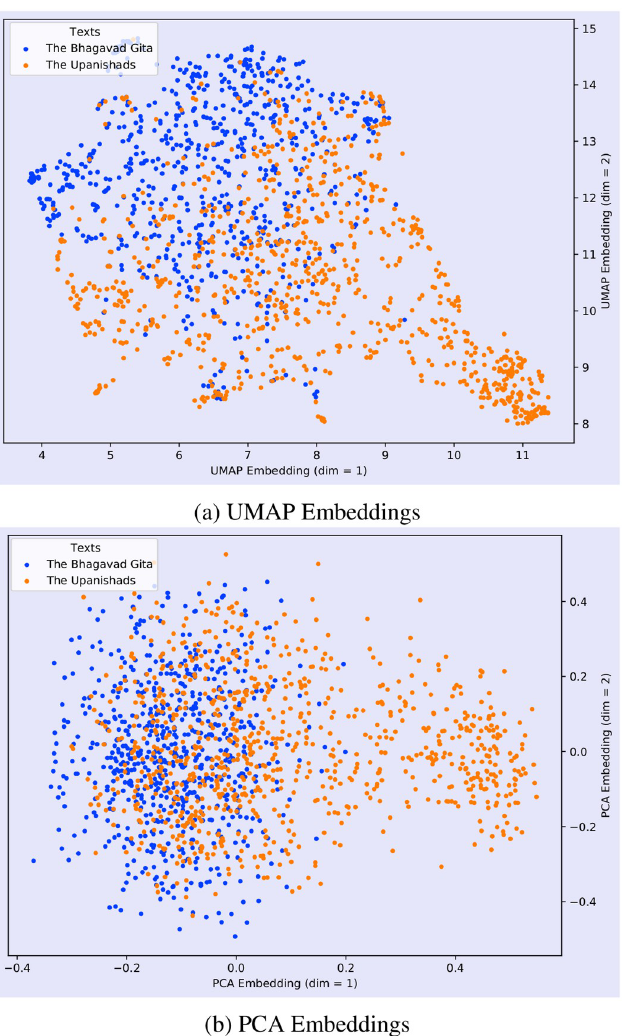
Fig 13. Comparison of dimensionality reduction and visualisation by PCA and UMAP for the combined semantic space of the Bhagavad Gita (Eknath Easwaran) and the Upanishads (Eknath Easwaran). Note that the PCA has 4.4% explained variance ratio for dim = 1 and 3.7% for dim = 2, taken from total of 500 dimensions in original data.